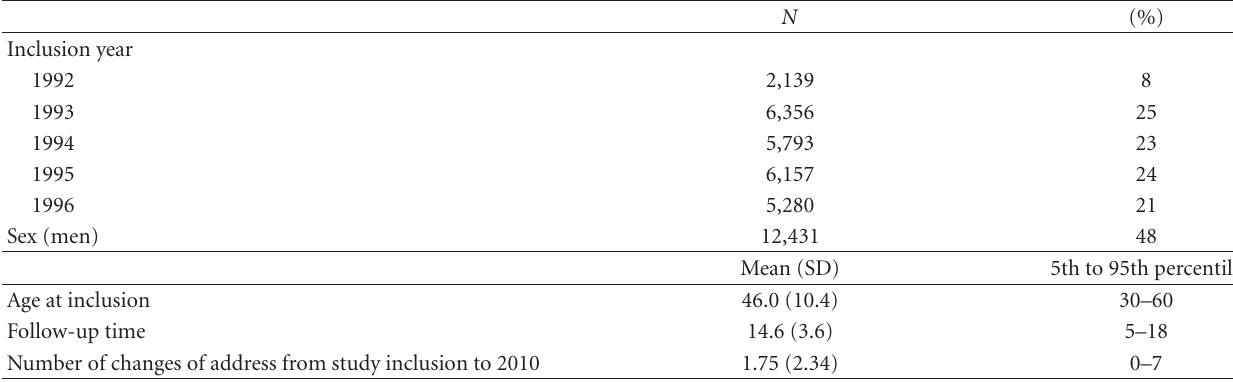
Table 1: Descriptive data of the cohort (25,725 observations).